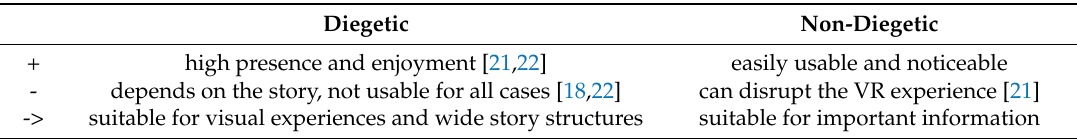
Table 4. Advantages and disadvantages of diegetic and non-diegetic methods. The third row indicates for which requirements the methods are